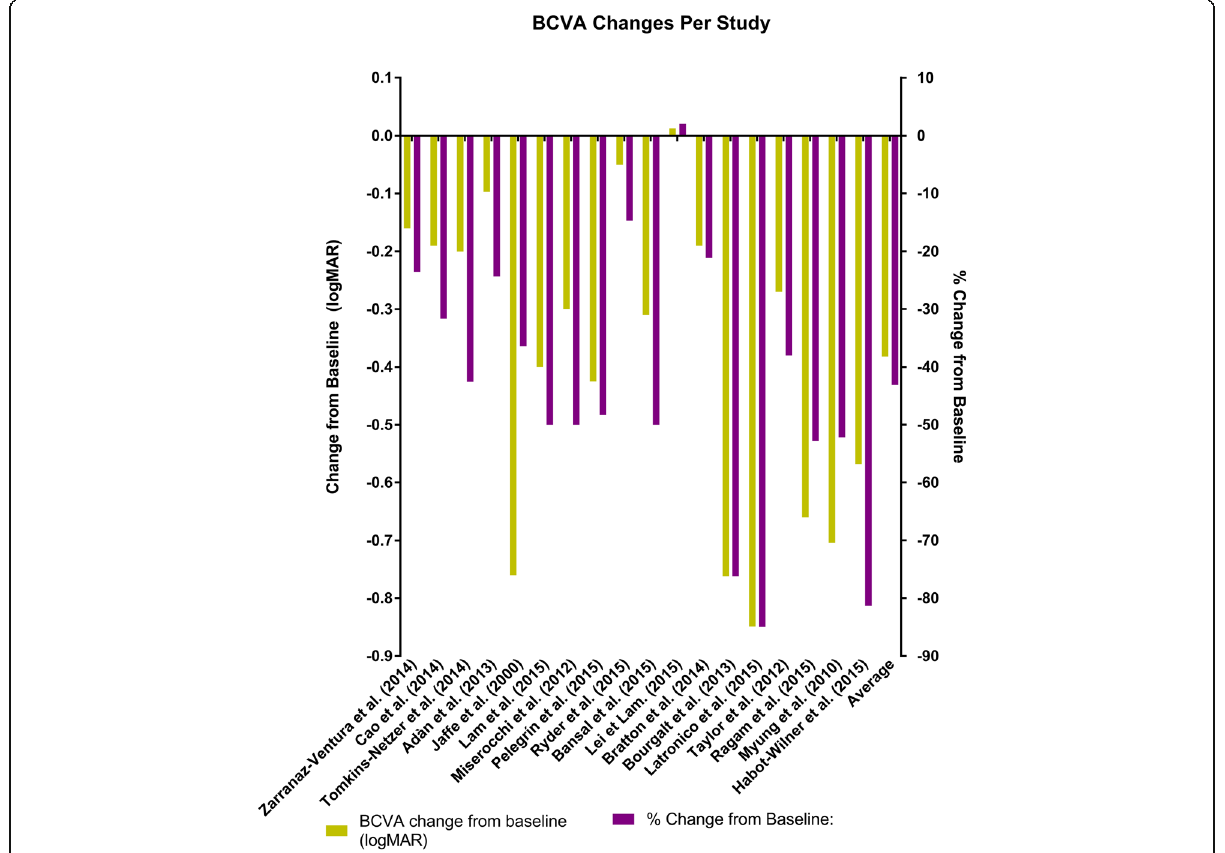
Fig. 3 Best corrected visual acuity calculated